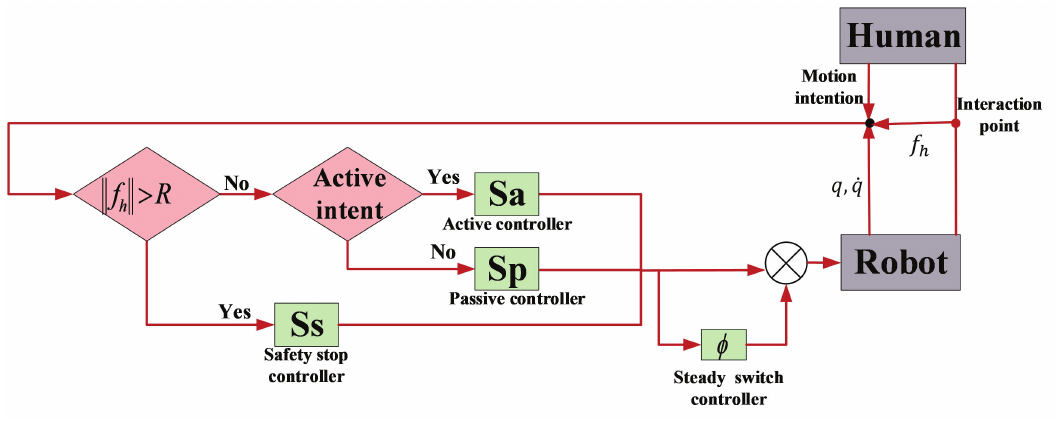
Figure 1. Schematic diagram of the